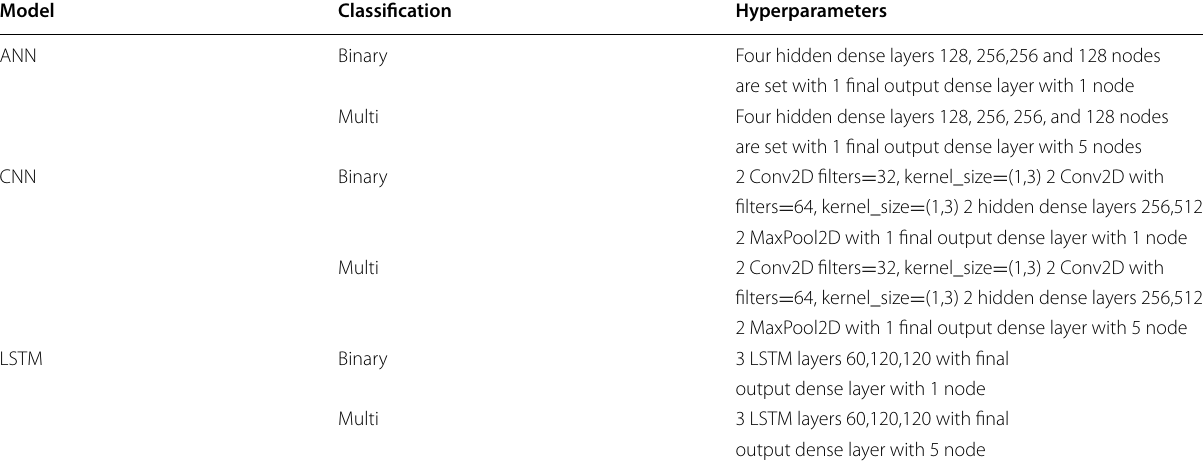
Table 4 Hyper-parameters detail in all classifiers